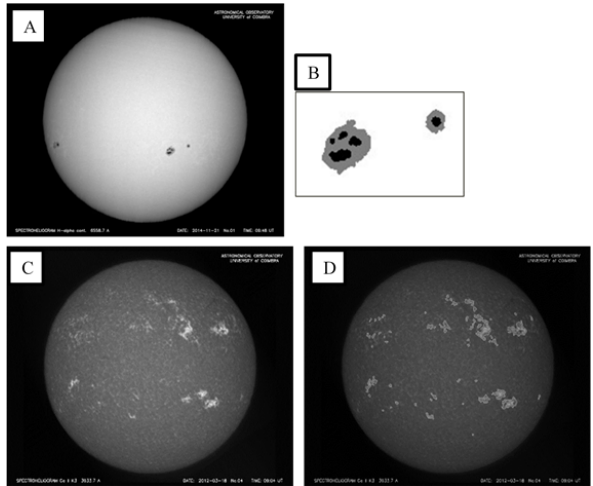
Figure 12. Sunspots observed on H α continuum image (A) and the results of the automatic detection method (B) [Source: Carvalho et al. (2016)]. Facular regions observed on CaII K3 image (C) and re- (D). Other examples can be consulted in Barata et al. (2018).